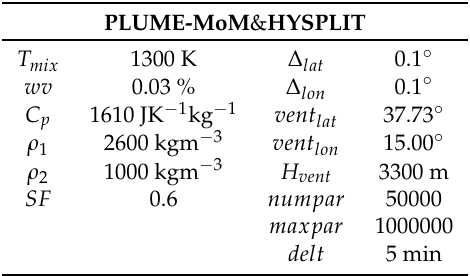
Table 2. Input parameters used for the PLUME-MoM&HYSPLIT simulations. T mix and wv are the temperature and the water vapor mass fraction of the eruptive mixture, while C p is the specific heat of the solid particles. Particles density was set according to Bonadonna and Phillips [82], with a linearly increasing density from ρ 2 to ρ 1 for particles with diameter in the range 2 mm - 8 µ m, constant density ρ 2 for particles with diameter > 2 mm and constant density ρ 1 for particles with diameter < 8 µ m. SF is particles shape factor. ∆ lat and ∆ lon is the resolution of the computational grid. Mt. Etna latitude and longitude coordinates are vent lat and vent lon respectively, while H vent is Mt. Etna elevation. numpar indicates the number of puffs released per cycle, while maxpar expresses the maximum number of puffs carried by the simulation. Finally, delt indicates HYSPLIT integration step in minutes. PLUME-MoM & HYSPLIT T mix 1300 K ∆ lat 0.1 ◦ wv 0.03